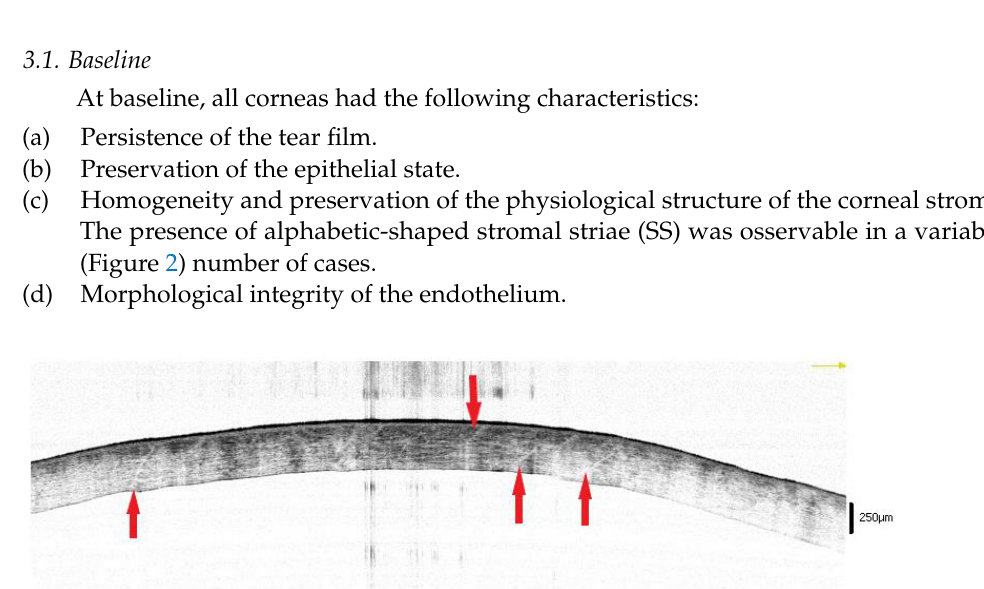
Figure 2. The black and white image highlights the presence of X- and V-shape and linear stromal striae (indicated with red arrows). This sign, initially considered an imaging artifact, constitutes a structural feature of the corneal tissue that has only recently been discovered (and it is still under study).